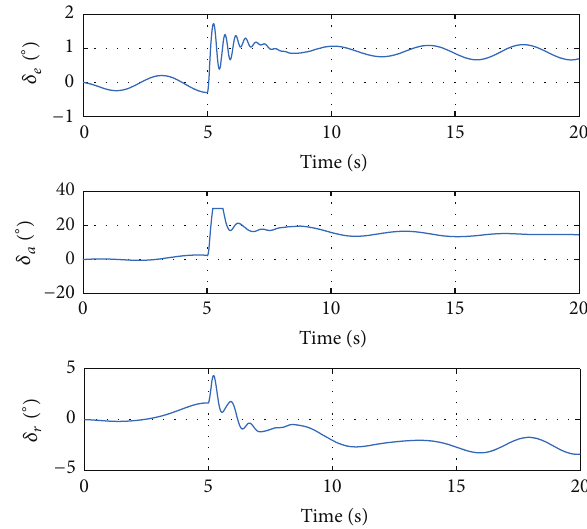
Figure 7: Control surface deflections in simulation with sinusoidal input